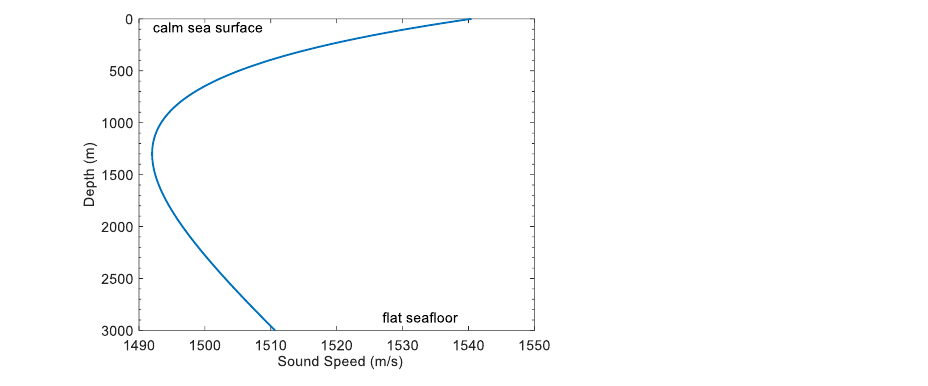
Figure 6. Simulated ocean environment with a calm sea surface, flat seafloor, and Munk sound speed profile.